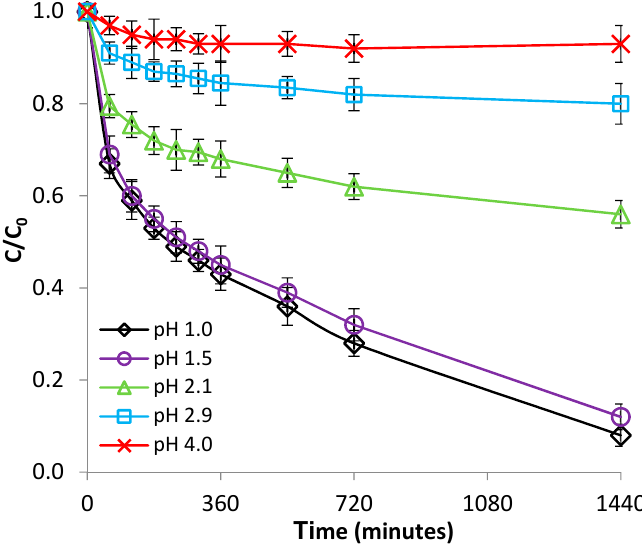
Figure 5. Effect of pH on Cr(VI) removal by Be-Fe(0).